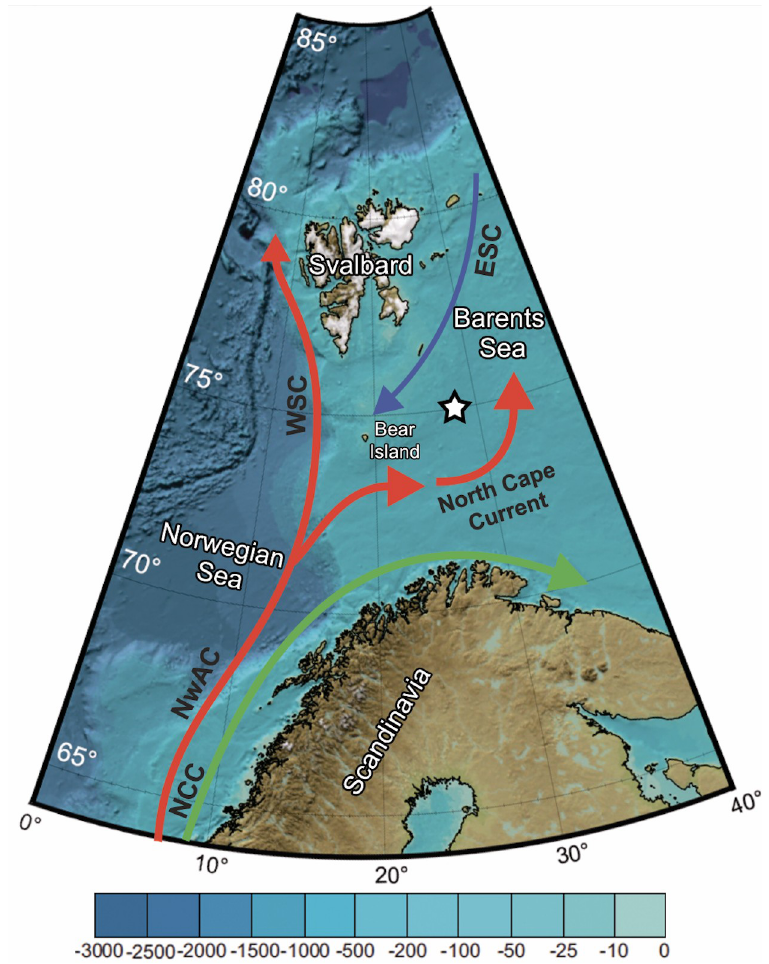
Fig 1. Schematic map of study area and main current systems in the Nordic Seas. White star indicates the crater area where plankton tows, box-cores and water sampling were conducted, detailed bathymetry can be found in Ofstad et al. [30]. Red lines are Atlantic Water inflows, blue line is Arctic Water outflows, and the green line is a coastal current. Abbreviations: NwAC Norwegian Atlantic current, WSC West Spitsbergen current, ESC East Spitsbergen current, NCC Norwegian Coastal Current. Current systems are based on Loeng [3]. Basemap from IBCAO 3.0